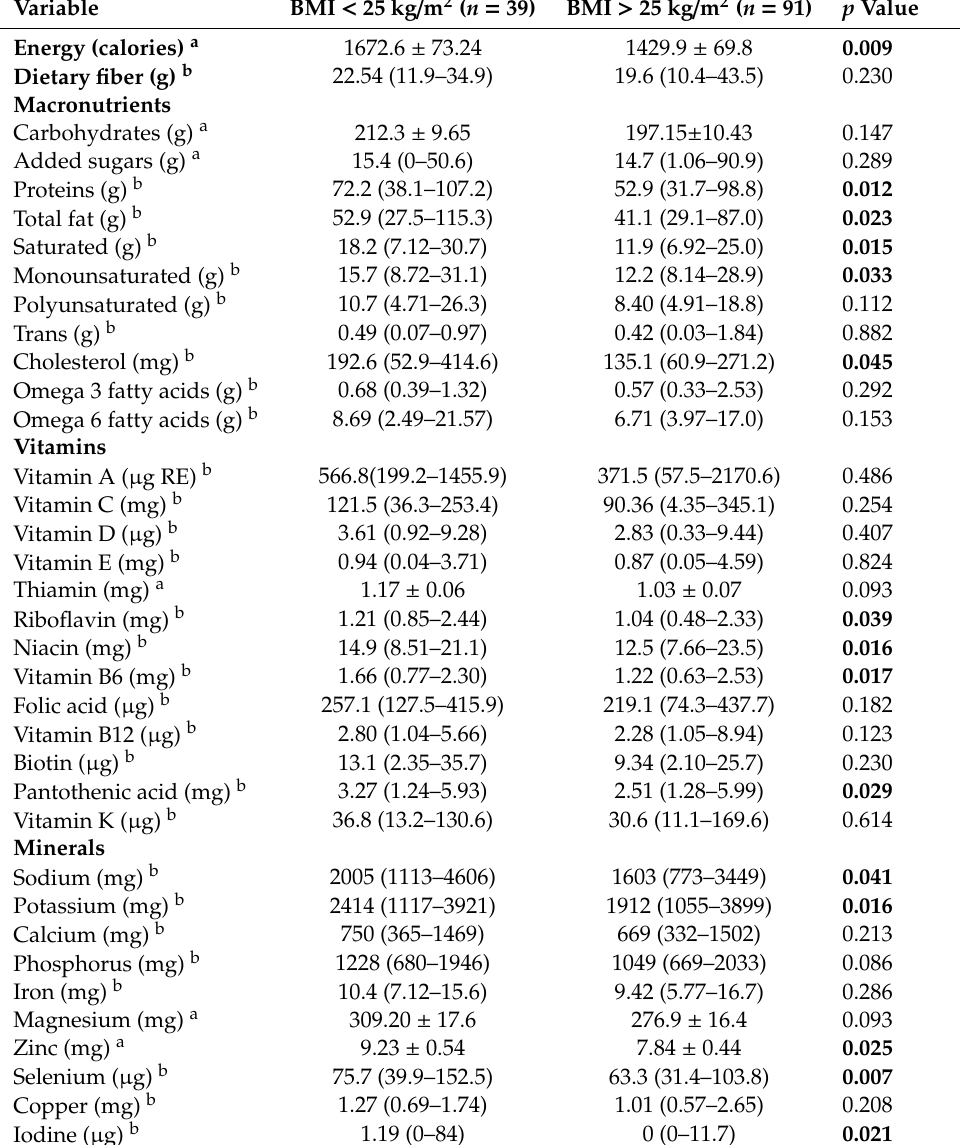
Table 4. Nutrient intake stratified according to the BMI of systemic lupus erythematosus